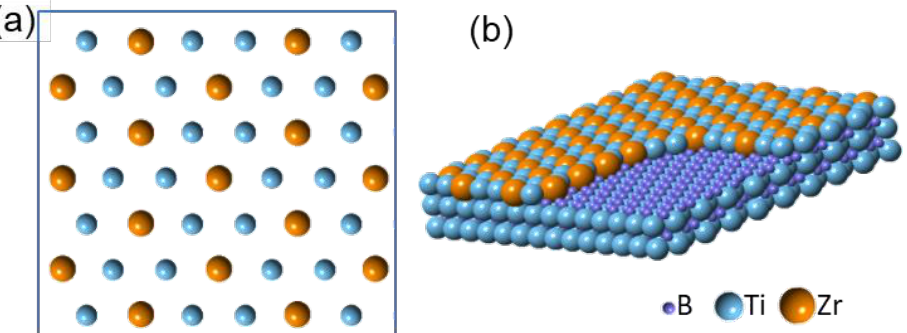
Figure 12. Crystal structure and chemistry of the Zr segregation monolayer (Ti 2 Zr 2DC) at Al/TiB 2 interface [26]. ( a ) In-plane arrangement of Zr (larger orange spheres) and Ti (smaller blue spheres) atoms in the Ti 2 Zr 2DC layer and ( b ) 3D construction of the Ti 2 Zr 2DC on (0 0 0 1)TiB 2 surface.